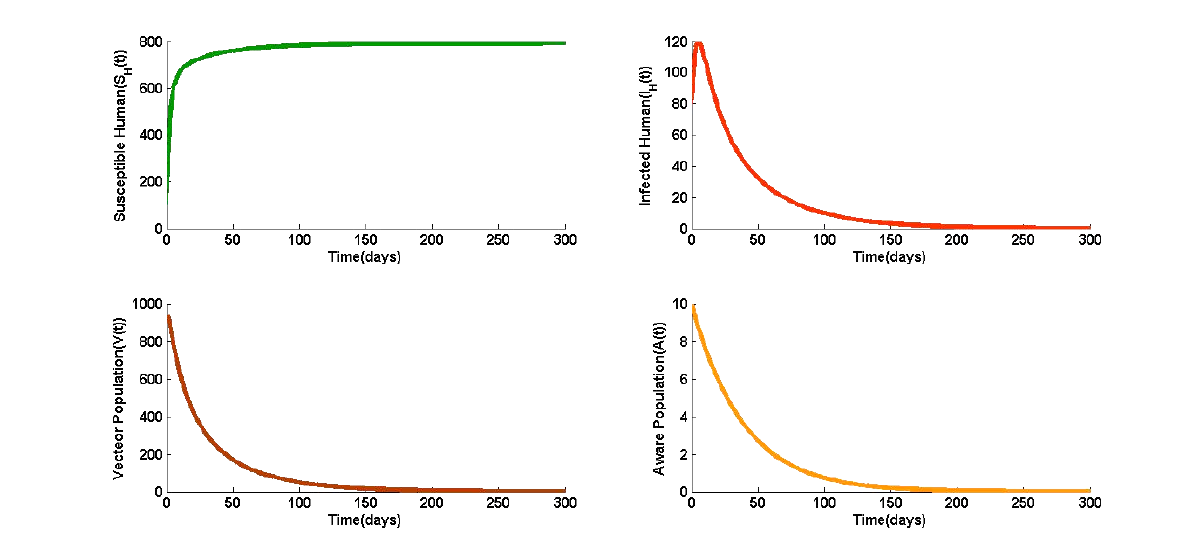
Fig. 2. Behavior of different population for R 0 < 1, when the system attains its disease-free state